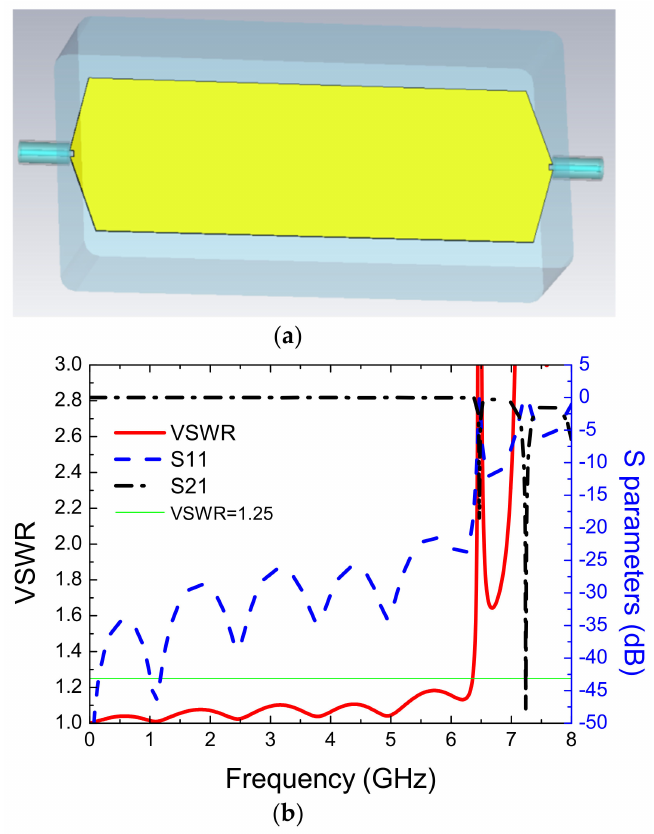
Figure 6. Long version IC-Stripline cell. ( a ) The model established in CST. ( b ) S-parameters and VSWR simulation